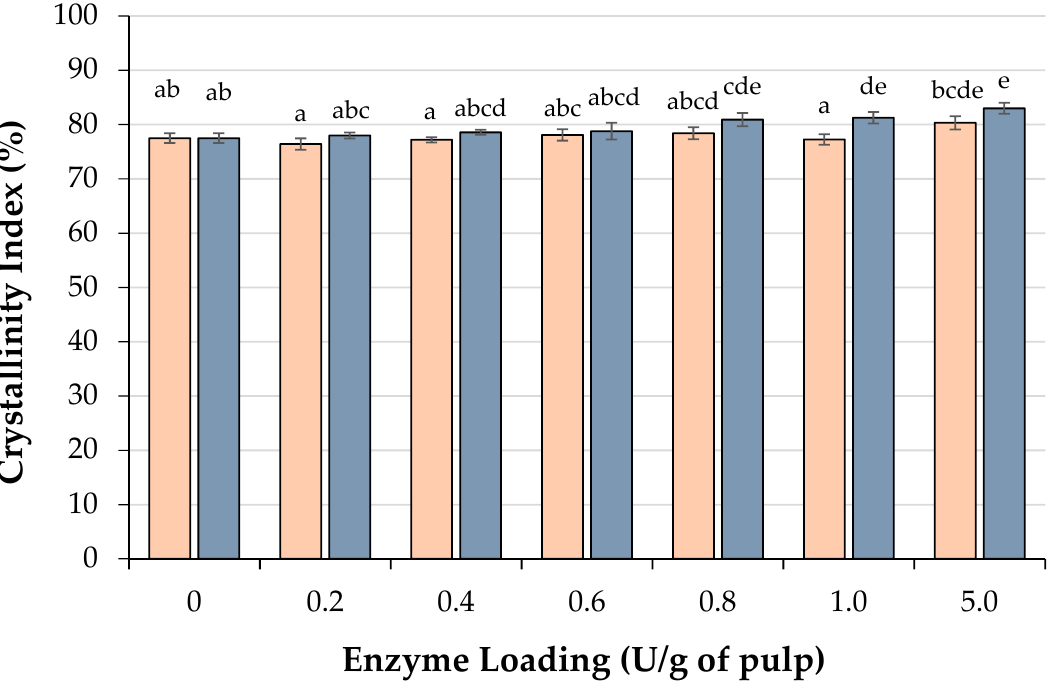
Figure 4. Crystallinity index as determined by XRD analysis. The solid residue recovered after treatment (or mock-treatment) of wood pulp with endoglucanases with (Endo-CBD+) or without (Endo-CBD − ) cellulose-binding domains were subjected to XRD analysis to determine crystallinity. Columns labelled with different letters indicate means that are statistically different at a 95% confidence level.